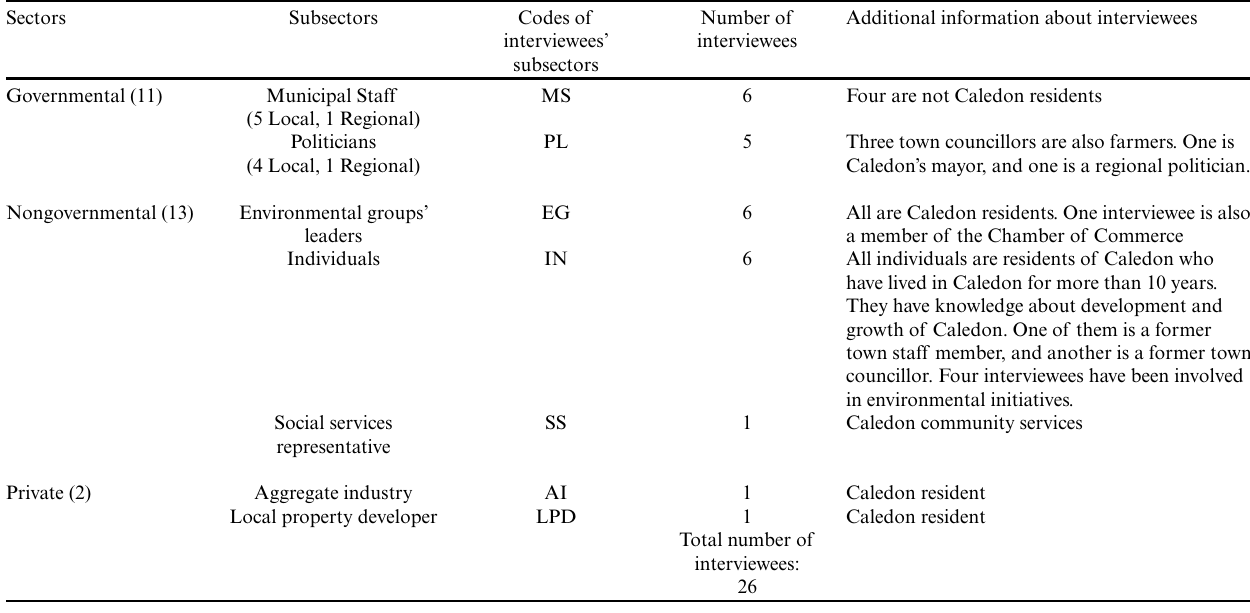
Table 2. Interviewees’ information by sectors